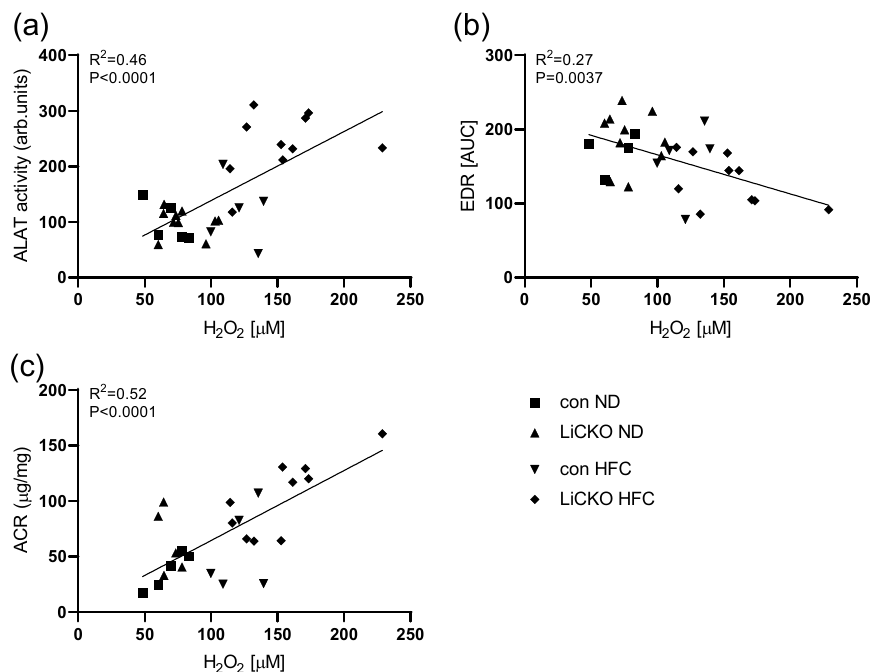
Figure 8. Correlations between liver and endothelial damage with oxidative state. ( a , c ) plasma ALAT and ACR activity correlated positively with serum H 2 O 2 at week 20; ( b ) EDR correlated negatively with serum H 2 O 2 at week 20.